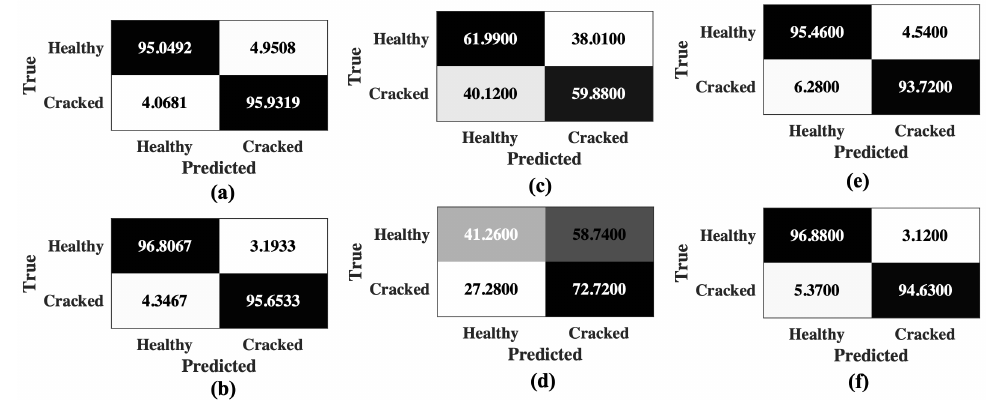
Figure 12. Confusion matrices for ( a ) K t 1 baseline DNN and ( b ) K t 2 baseline DNN. Confusion matrices for ( c , d ) transductive analysis, and ( e , f ) mixed learning. Reprinted ( a – d ) from [27]